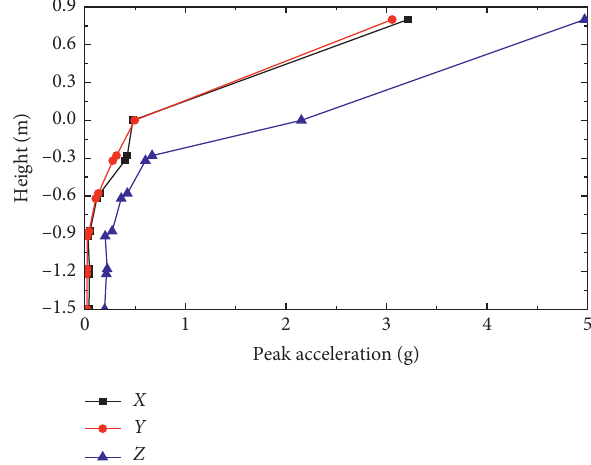
Figure 8: Distribution of peak acceleration at each measuring point in different directions.